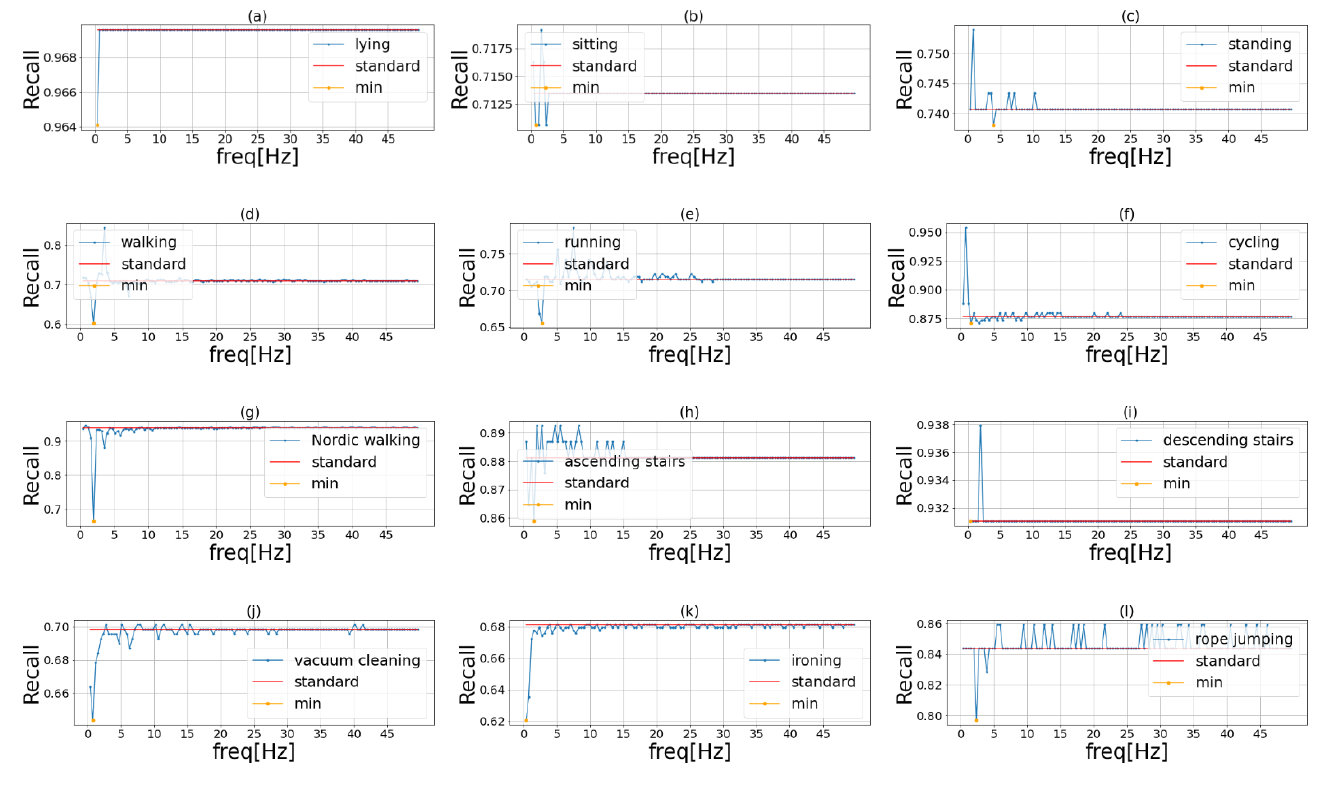
Sensors 2023 , 23 , x FOR PEER REVIEW 11 of 14 Figure 5. Important frequency of each activity in PAMAP2. The blue line in the graph shows the recognition accuracy when we masked the frequencies of the original sensor data in order. The red line shows the recognition accuracy when we used the original data. The yellow point is the lowest recognition accuracy when we used the frequency masked data. Each of these activities is ( a ) lying, ( b ) sitting, ( c ) standing, ( d ) walking, ( e ) running, ( f ) cycling, ( g ) Nordic walking, ( h ) ascending stairs, ( i ) descending stairs, ( j ) vacuum cleaning, ( k ) ironing, and ( l ) rope jumping.